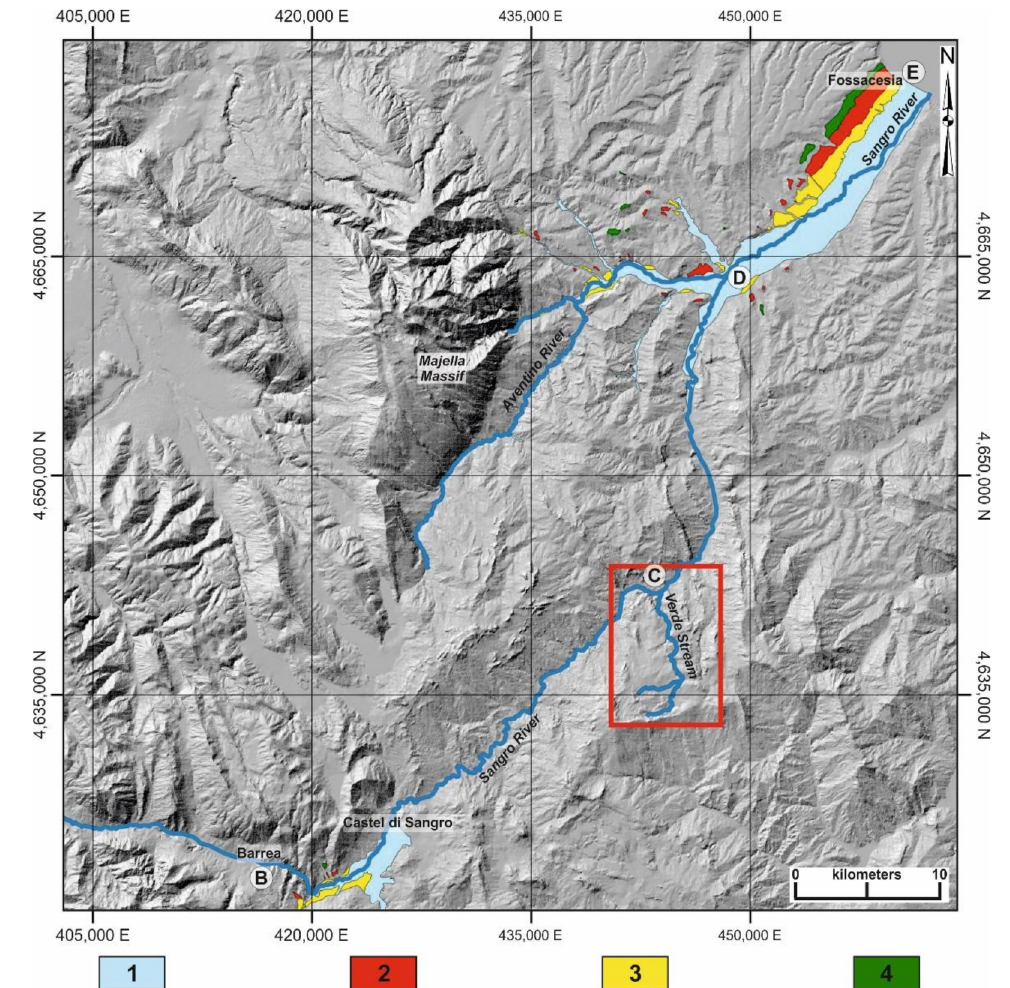
Figure 3. Fluvial terraces schema of the middle-lower Sangro River valley. In blue, the drainage network; the red box frames the drainage basin object of this work. Letters refer to Figure 1 (modified from [2,12,34]). Legend: (1) fourth order terrace—alluvial plane (Holocene); (2) third order terrace (Late Pleistocene); (3) second order terrace (late Middle Pleistocene); (4) first order terrace (Middle